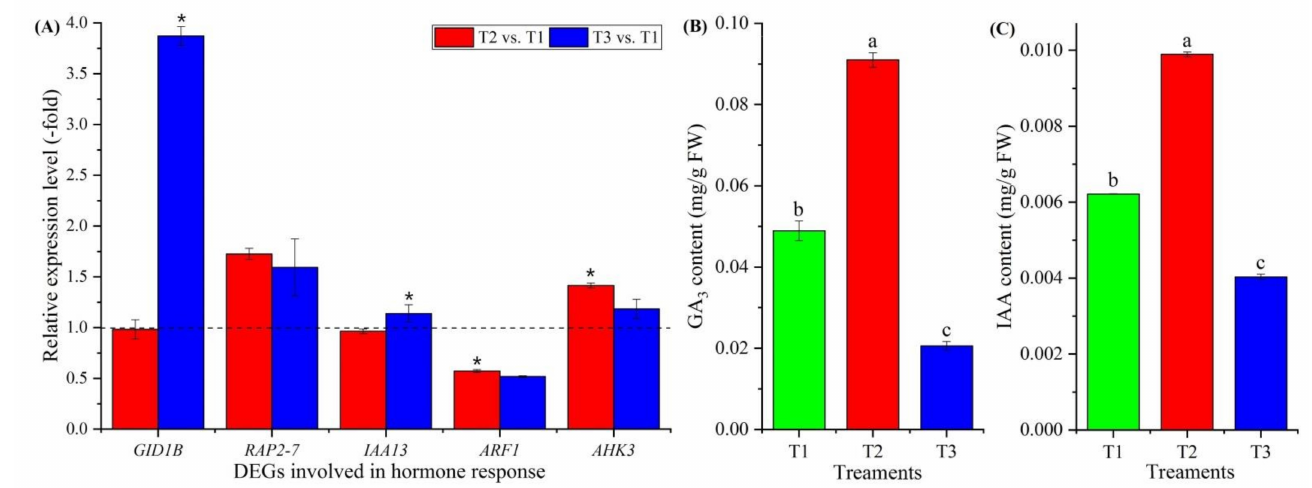
Figure 8. Expression levels of 5 genes involved in hormone response at T2 vs. T1 and T3 vs. T1 ( A ), and changes in GA 3 and IAA contents at T1, T2 and T3 ( B , C ). Here and below, “*” represents a significant difference at the p < 0.05 level between T2 vs. T1 and T3 vs. T1 for the same gene; the use of different letters represents a significant difference ( p < 0.05) at different temperature treatments.